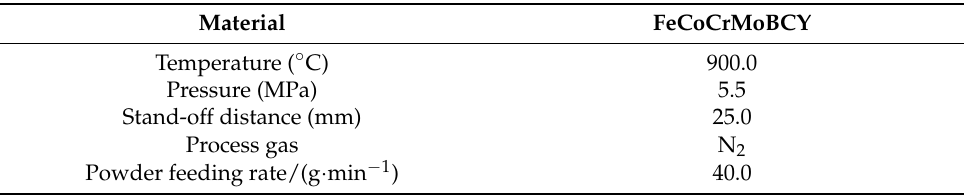
Table 1. CS parameters for the FAA coating.